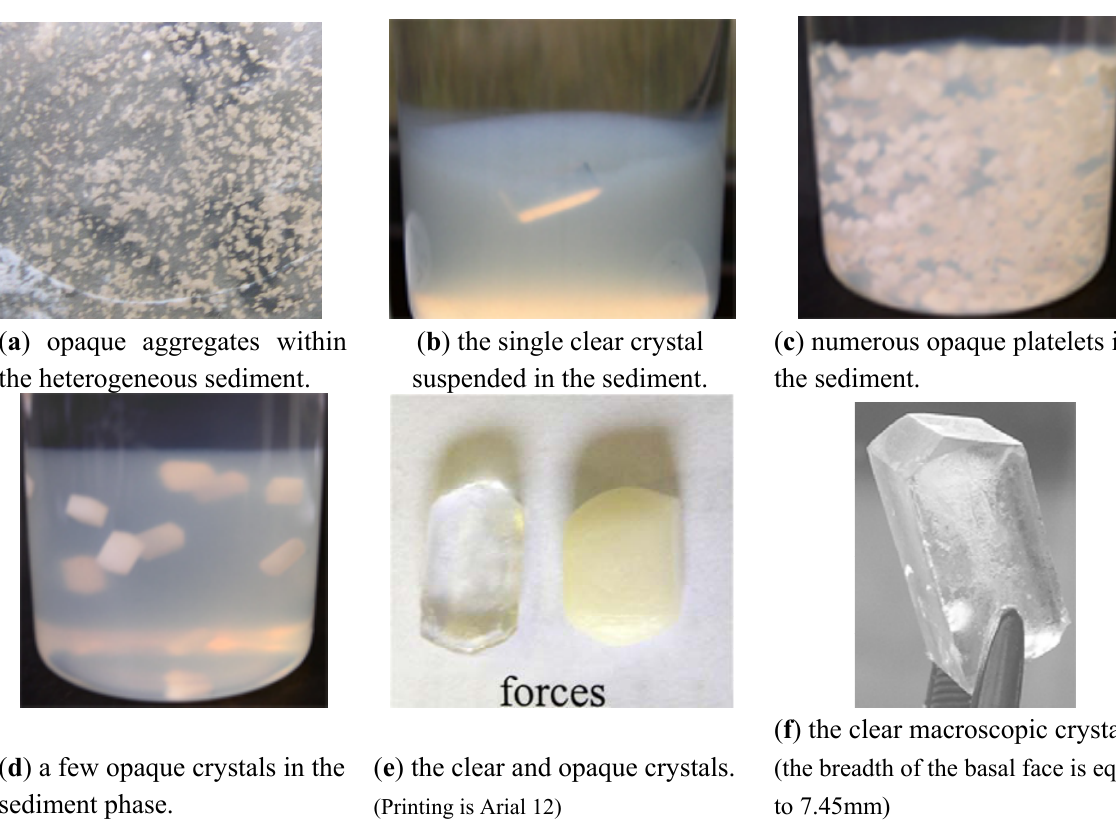
Figure 6. Representation of different figures of the settled